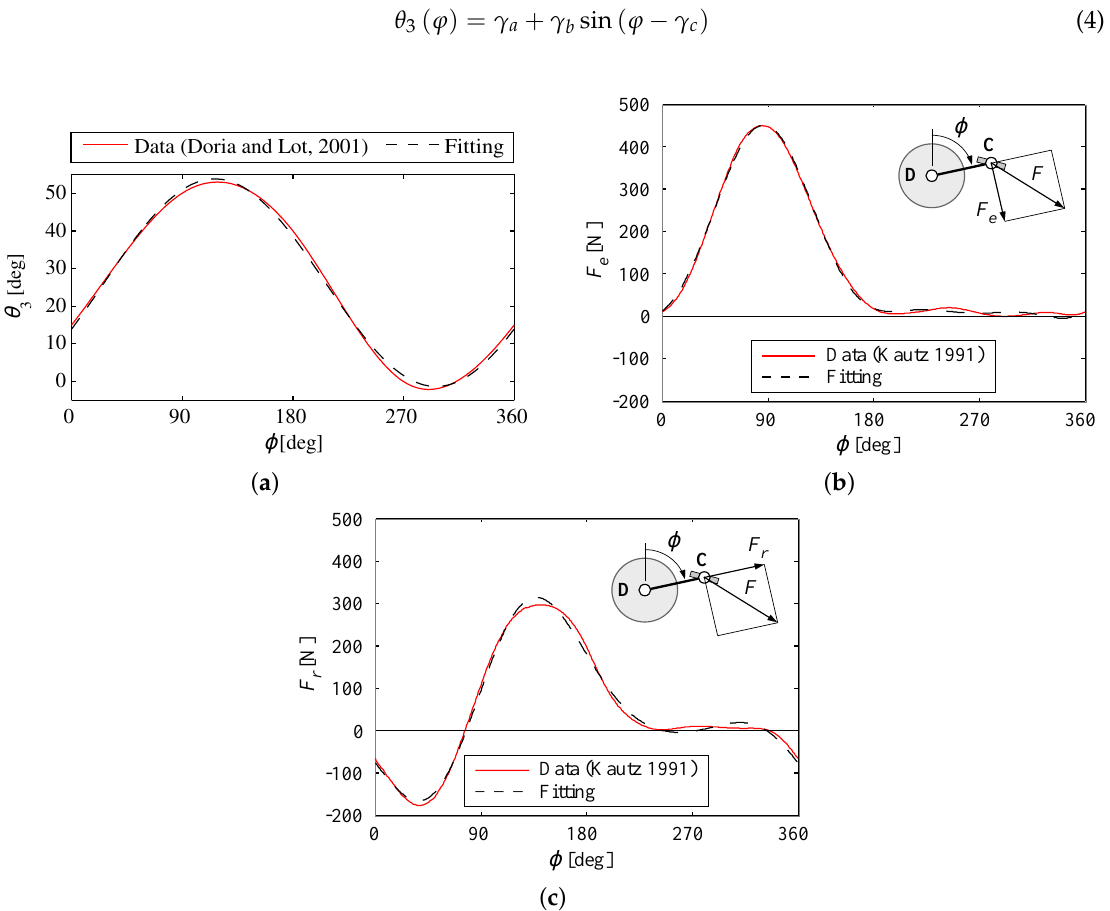
Figure 2. ( a ) foot angle θ 3 vs. crank angle ϕ : data from [31] and fitting obtained by Equation (4); ( b , c ) force components F e and F r vs. crank angle ϕ ; data from [36] and fitting obtained by Equation (11); ˙ ϕ = 90rpm, ¯ P r =